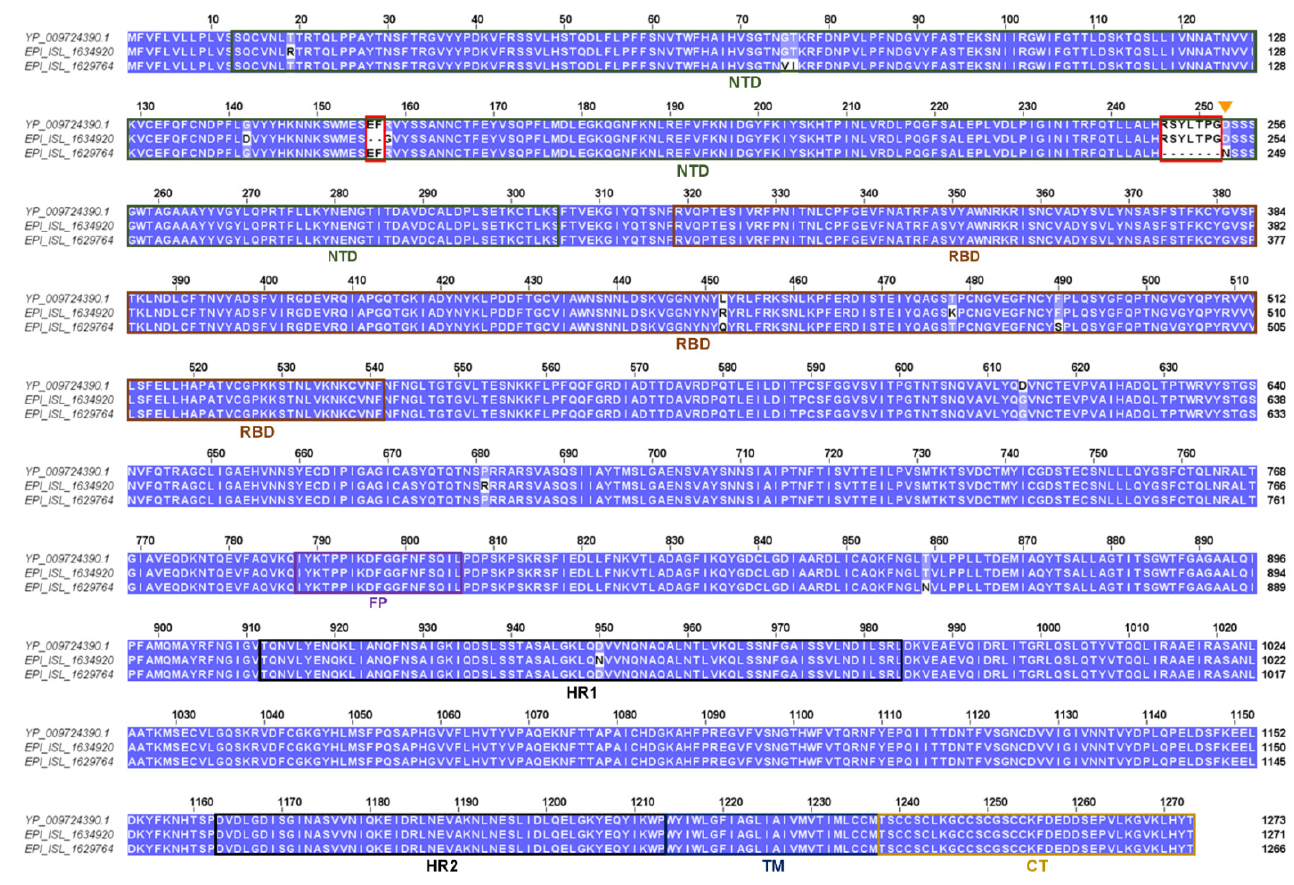
Figure 1. Sequence comparison between the Wuhan reference (yp_009724390.1) and the Lambda (EPI_ISL_1629764) and Delta (EPI_ISL_1634920) variant S proteins. Red boxes indicate the deletions within the N-terminal domains (NTD) while the orange triangle marks the potential new N-glycosylation site in the Lambda variant . Colored, labelled boxes indicate the sequence position of the Spike domains. NTD, RBD, FP, HR1, HR2, TM, and CT mean N-terminal domain, Receptor Binding Domain, Fusion peptides, Heptad repeat 1 and 2, Transmembrane domain, and C-terminal domain, respectively. Conserved columns have a blue background. Table 1. Summary of analysis of Spike protein mutations by DynaMut. The differences in free energy were estimated in comparison to the Wuhan sequence. The program does not include deletion mutants.